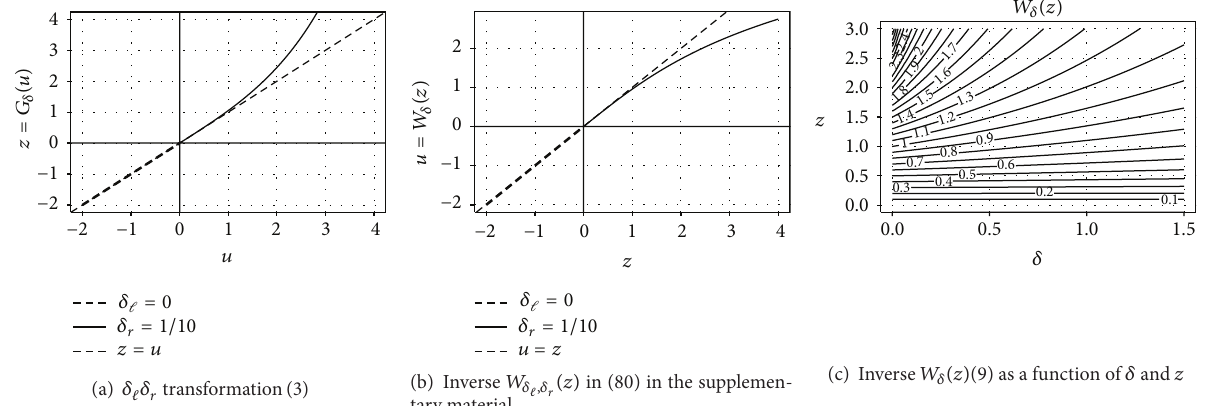
Figure 3: Transformation and inverse transformation for 𝛿 ℓ = 0 and 𝛿 𝑟 = 1/10 : identity on the left (same tail behavior) and a heavy-tailed transformation in the right tail of input 𝑈